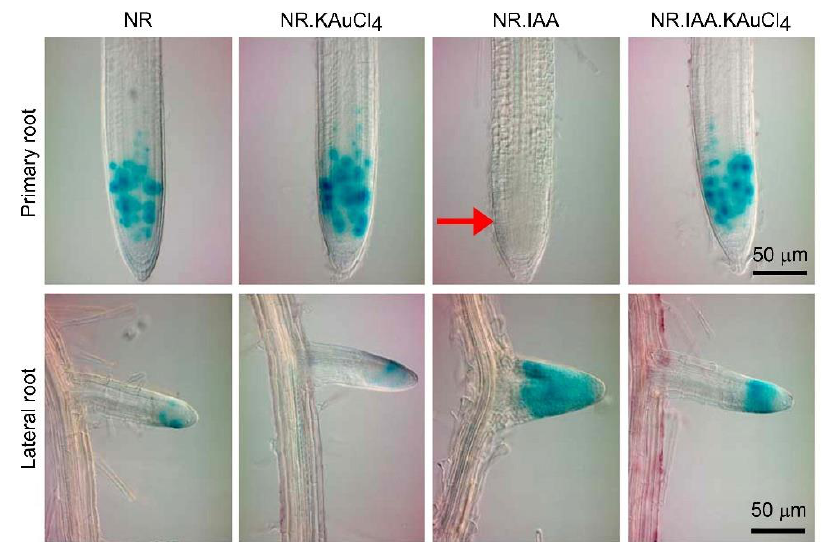
Figure 6. KAuCl 4 restored the inhibitory effect of IAA on the meristematic cell proliferation of the primary and lateral roots. The transgenic Arabidopsis seedlings harboring the cell division marker CycB1; 1::CDB- uid A reporter gene were initially grown hydroponically in the NR medium for 7 d and then transferred to the NR, NR.KAuCl 4 , NR.IAA, and NR.IAA.KAuCl 4 media for further 7 d, as described in the legend of Figure 5. Roots were harvested for the histochemical GUS expression analysis of CycB1; 1::CDB- uid A in the primary and lateral roots. The red arrow indicates the effect of NR.IAA on perturbation in the meristematic cell proliferation in the primary root.